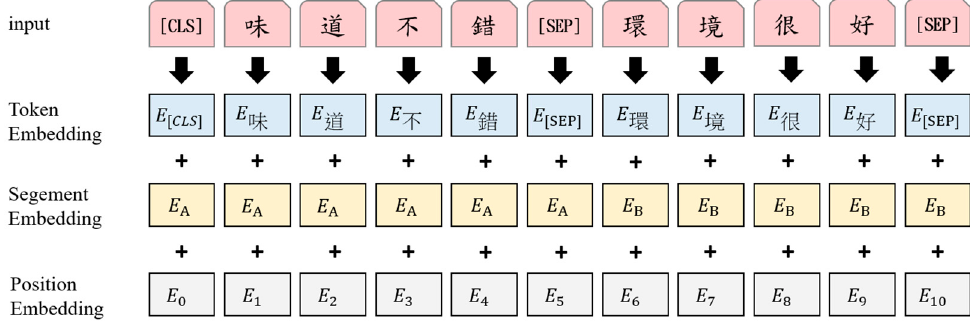
Figure 2. Input representation used by BERT. Remark: Translation of the sentence in the example is “ 味道不錯 (the taste is good); 環境很好 (the environment is nice)”. BERT is trained using two unsupervised tasks: the masked language model (MLM)